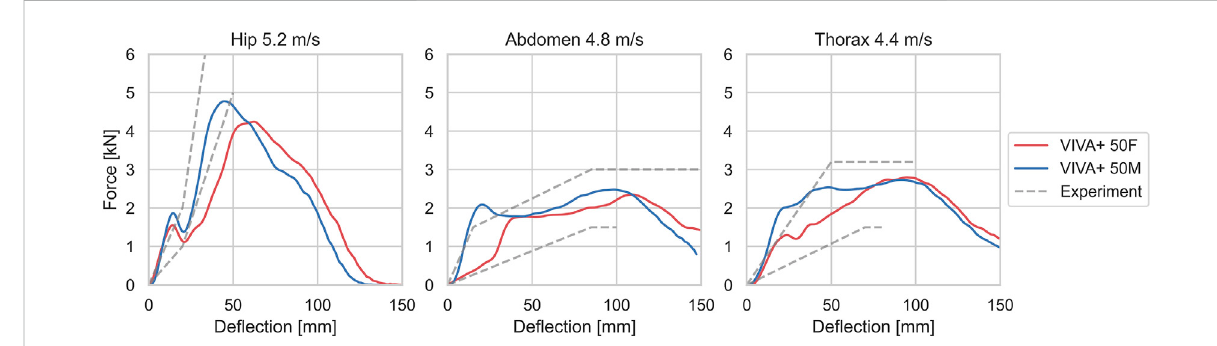
FIGURE 8 Force-de fl ection curves from simulations, compared to corridors for low-speed experiments from Viano et al.,